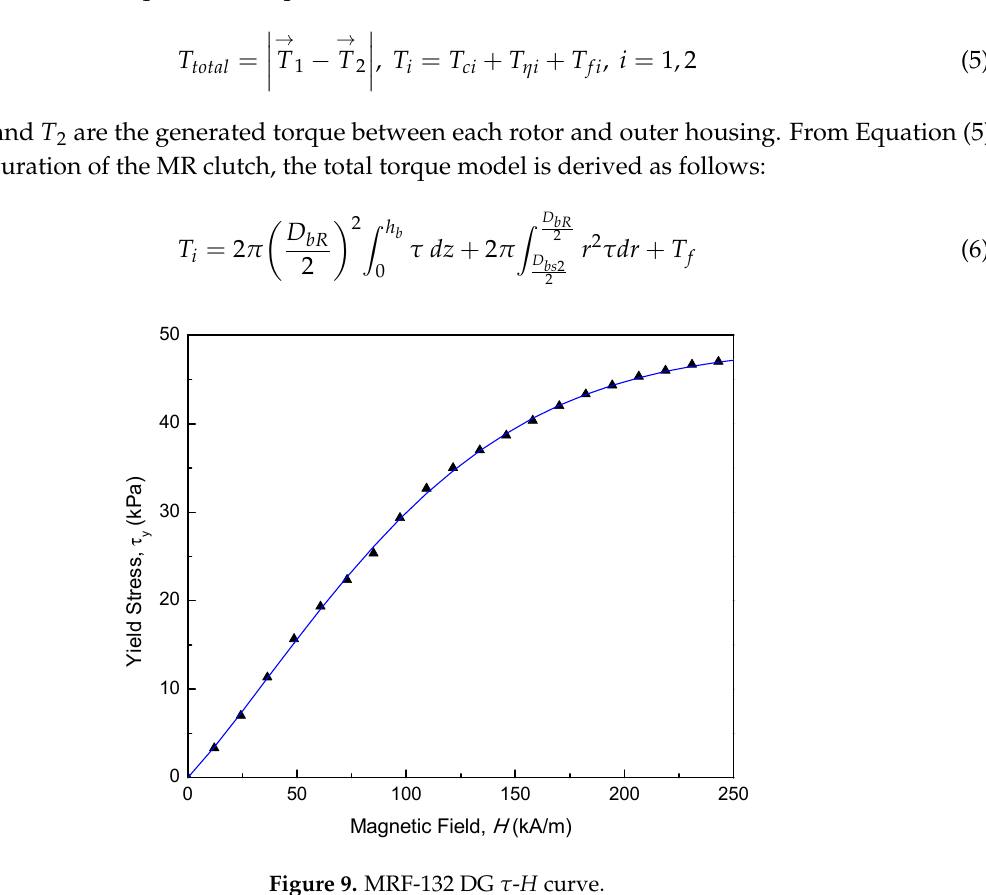
Figure 9. MRF-132 DG 𝜏 - H curve.